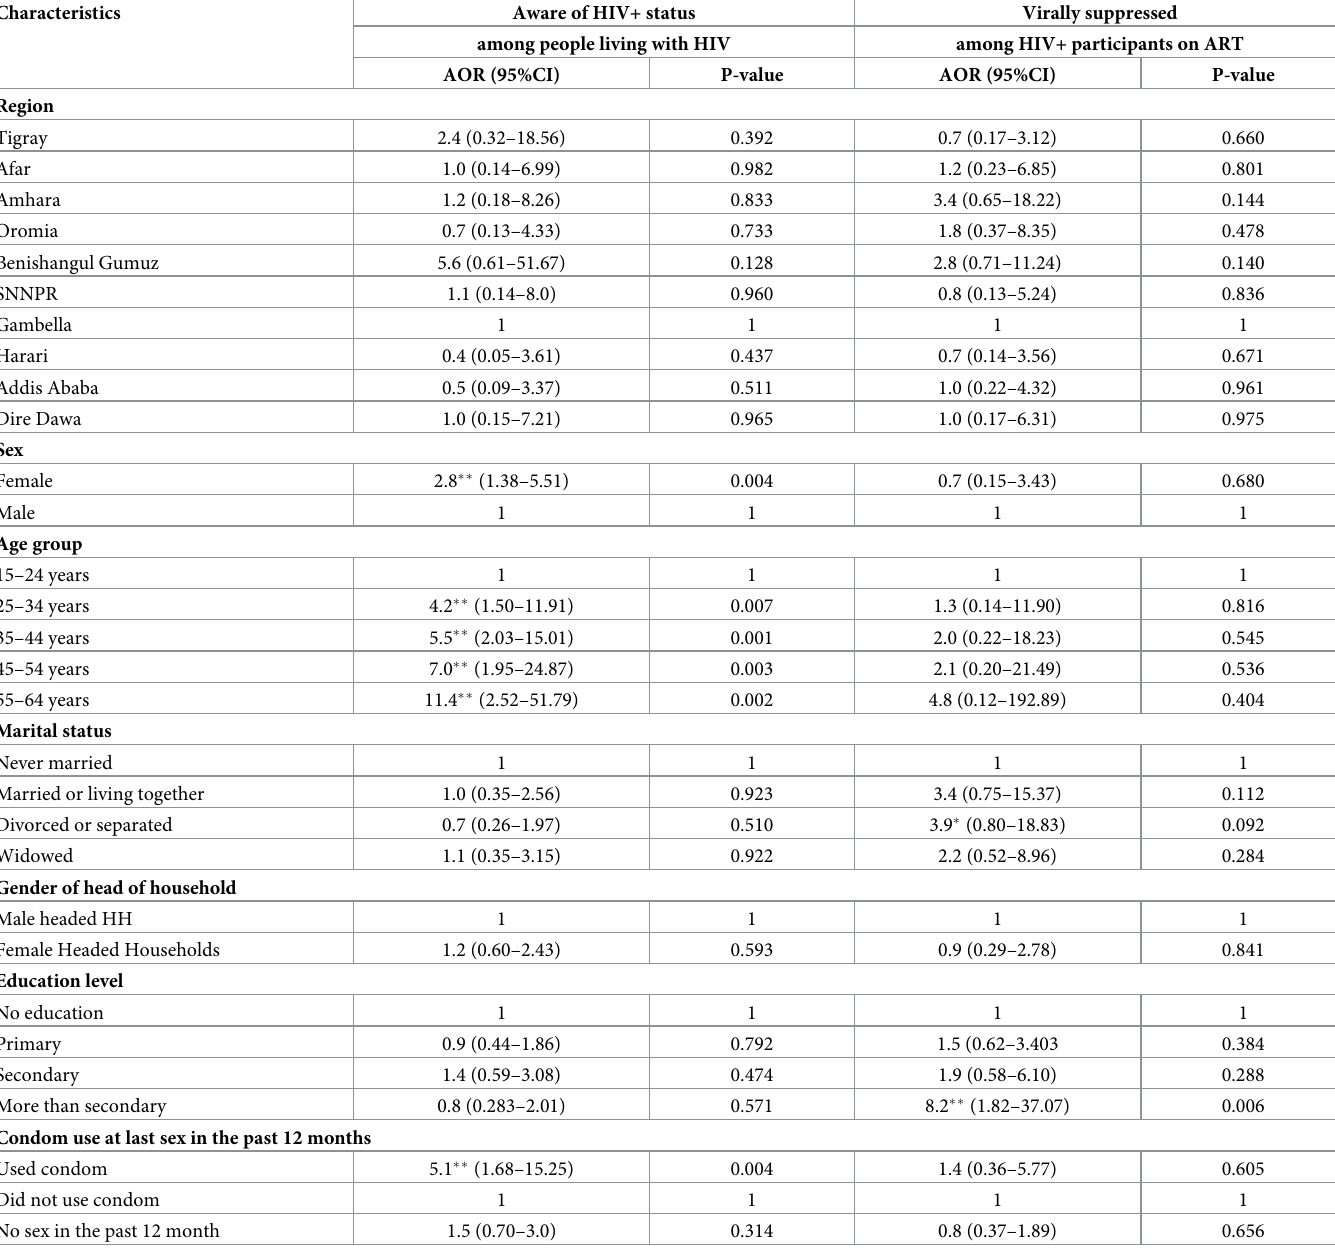
Table 3. Factors associated with HIV positive awareness among people living with HIV and viral load suppression among HIV positive adult participants, Ethiopia population-based HIV impact assessment, 2017–2018 � .